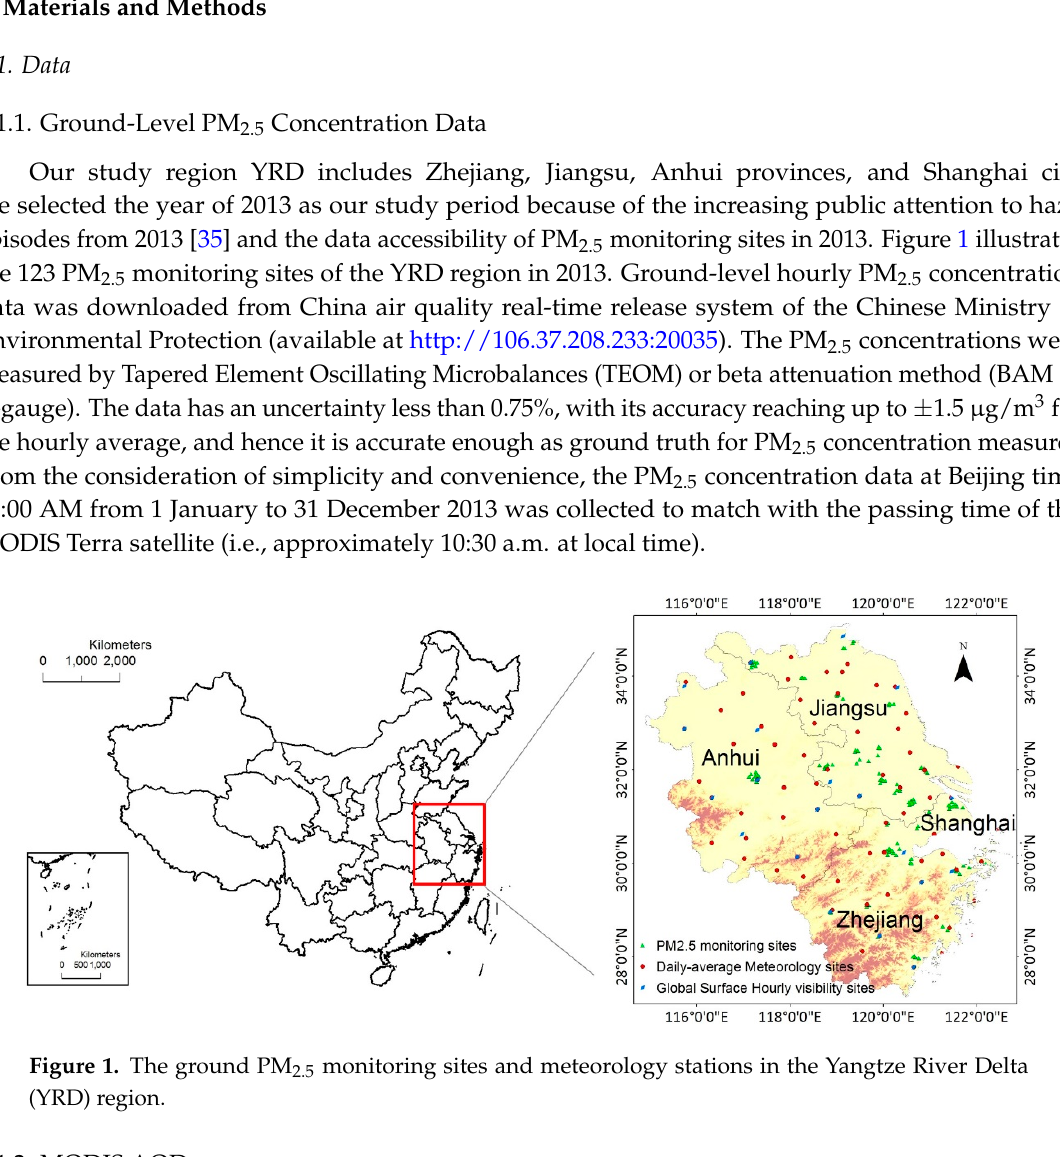
Figure 1. The ground PM 2.5 monitoring sites and meteorology stations in the Yangtze River Delta ( YRD ) region.